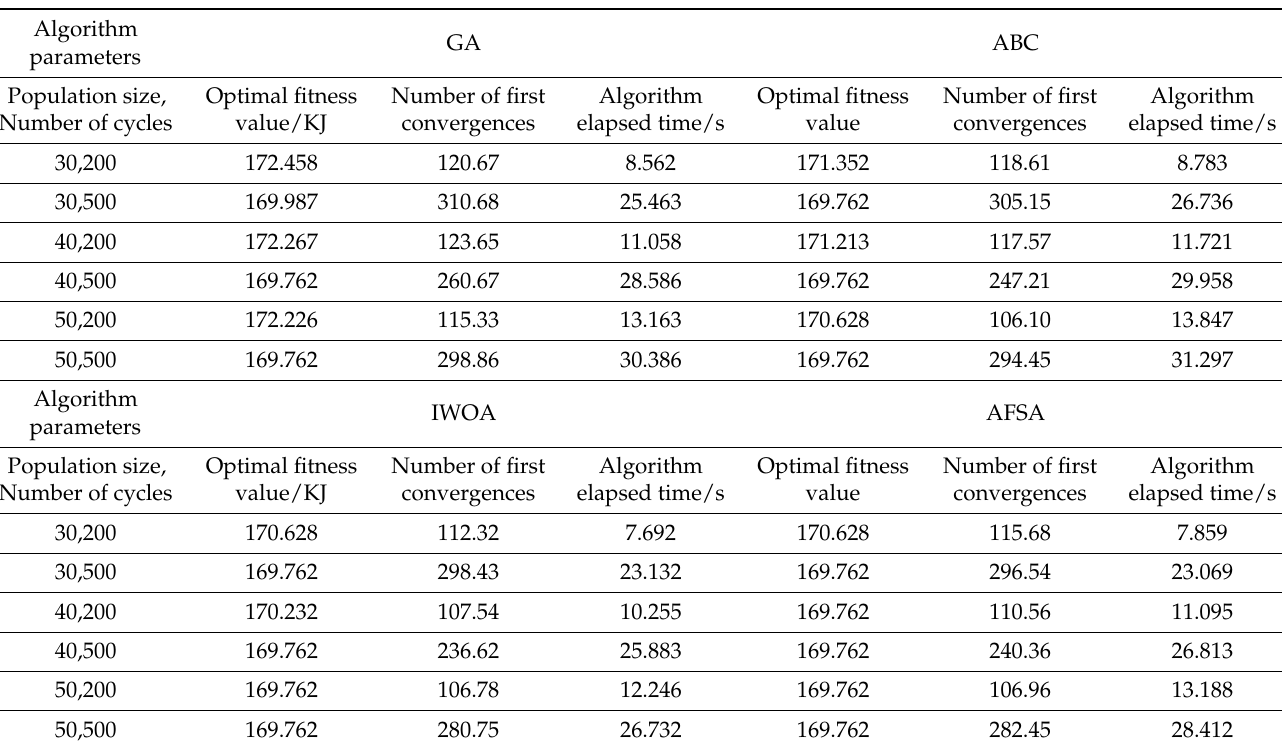
Table 2. Algorithm convergence comparison with multiple sets of